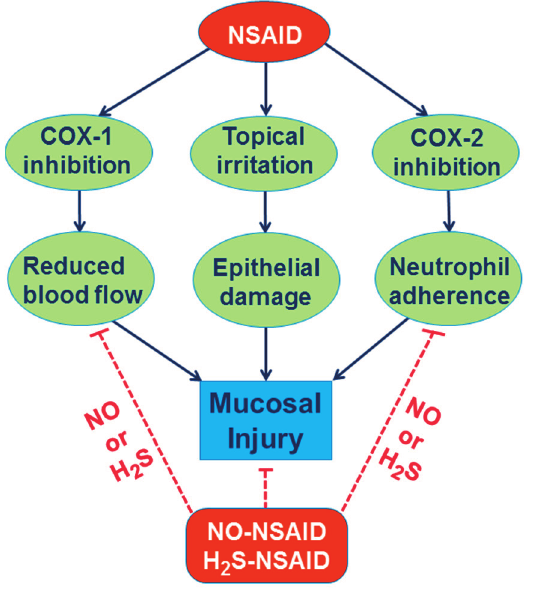
Figure 4. NO and H 2 S gastroprotection against NSAID-induced gastric